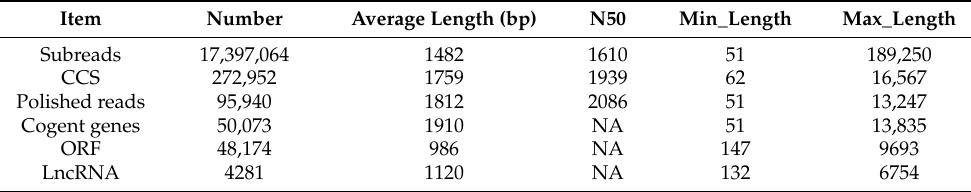
Table 1. Characteristics of Chosenia arbutifolia transcriptome sequences.